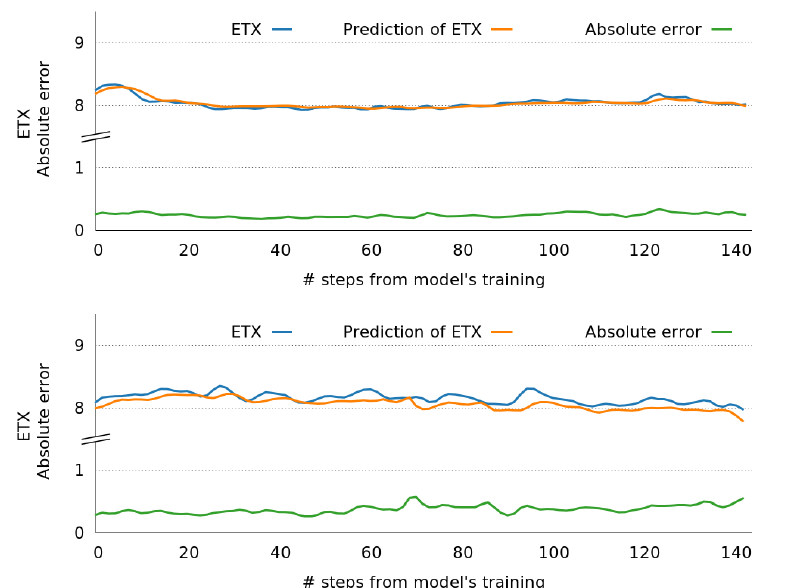
Figure 14. Evolution of the average ETX, the average prediction and the average absolute error for: ( top ) 12:00–00:00 and ( bottom )